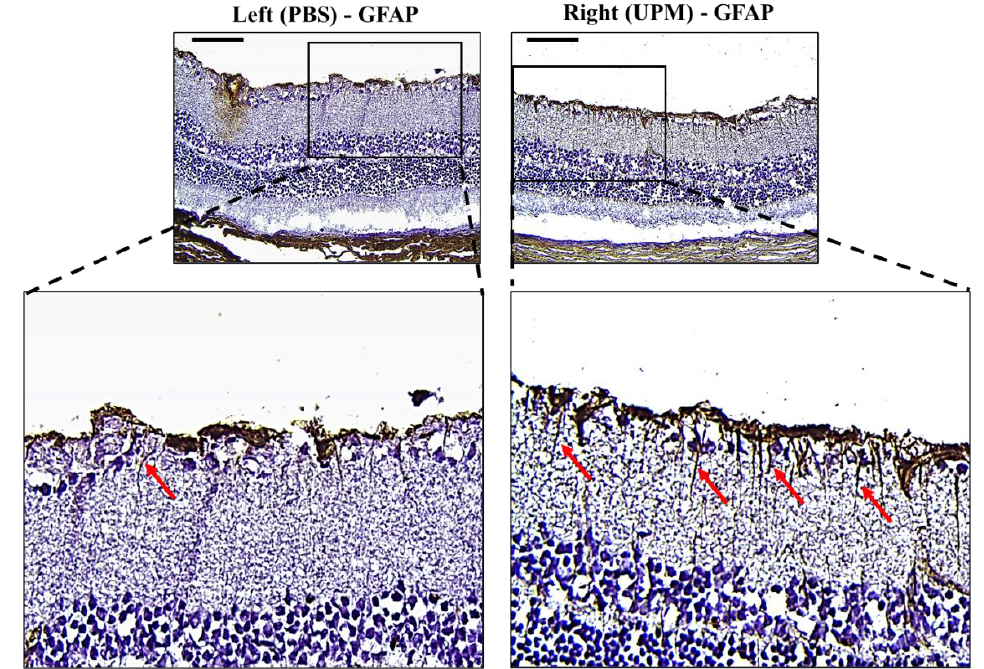
Figure 9. Effect of long-term exposure to UPM on retinal GFAP expression. Images of immunohistochemical staining against GFAP of samples taken from the retinas at 16 weeks. The scale bars indicate 100 μm at 200× magnification. The enlarged image of the right retina showed a sharp and penetrating shape of GFAP from the retinal inner surface (red arrows).